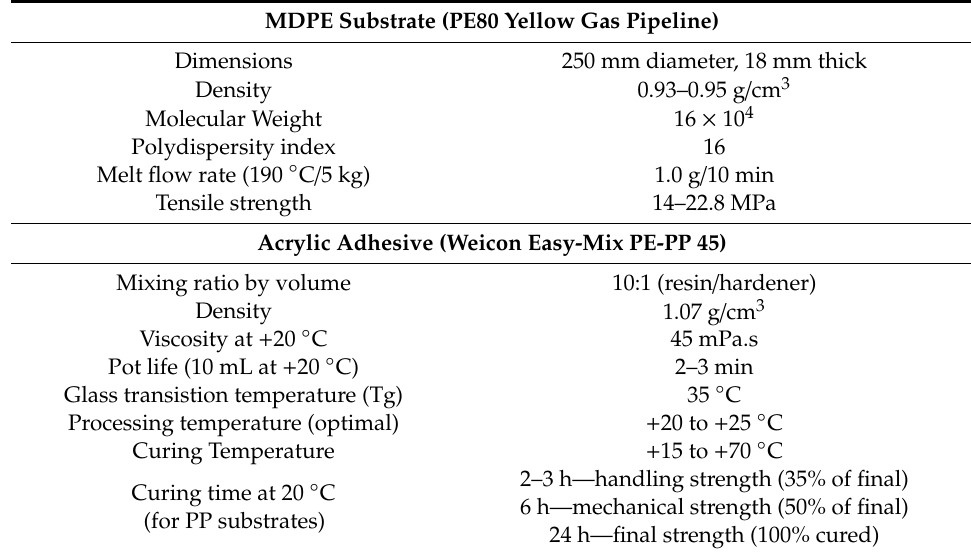
Table 1. Key properties of the MDPE substrate and acrylic adhesive (Data from